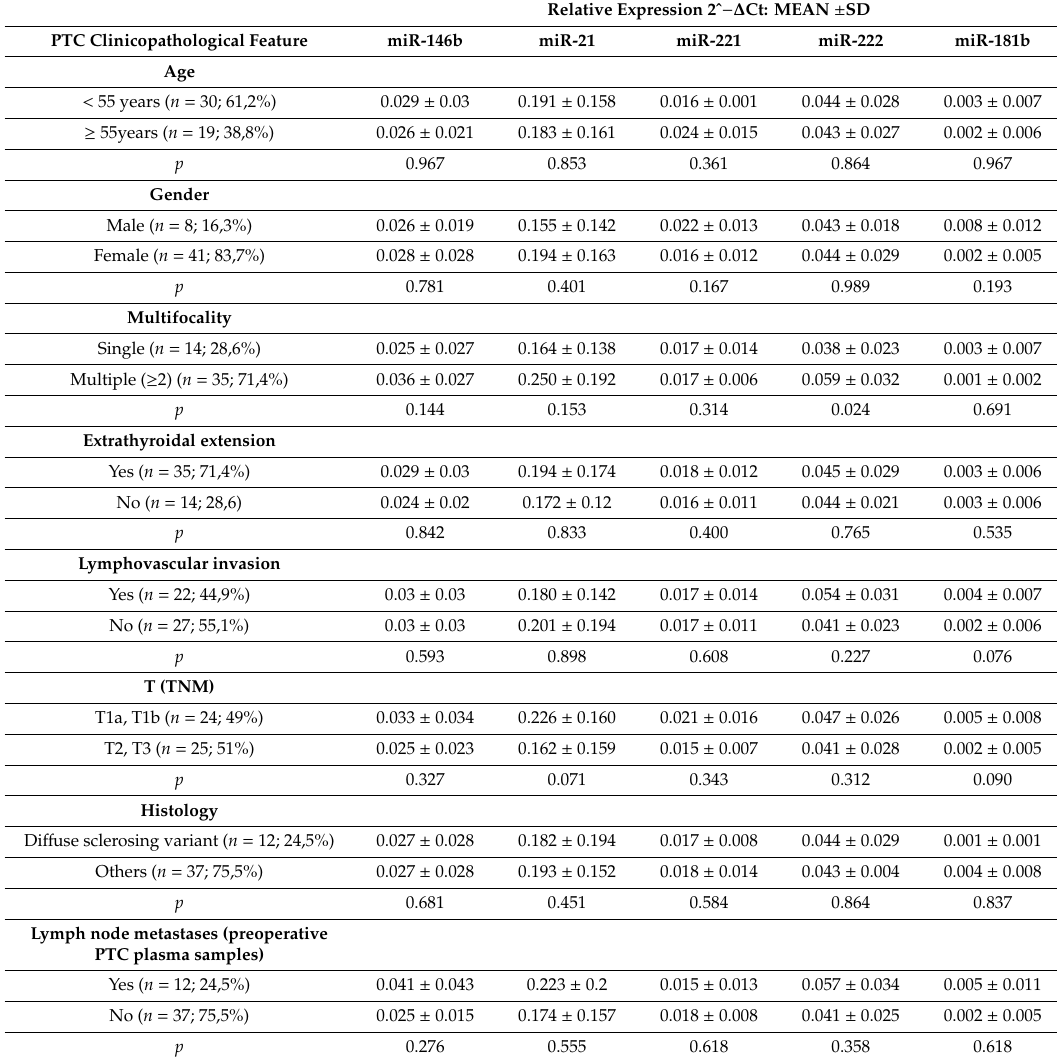
Table 3. Clinicopathological features of papillary thyroid cancer (PTC) and relative expression of miR (-146b, -221, -21, -222, -181b) in plasma